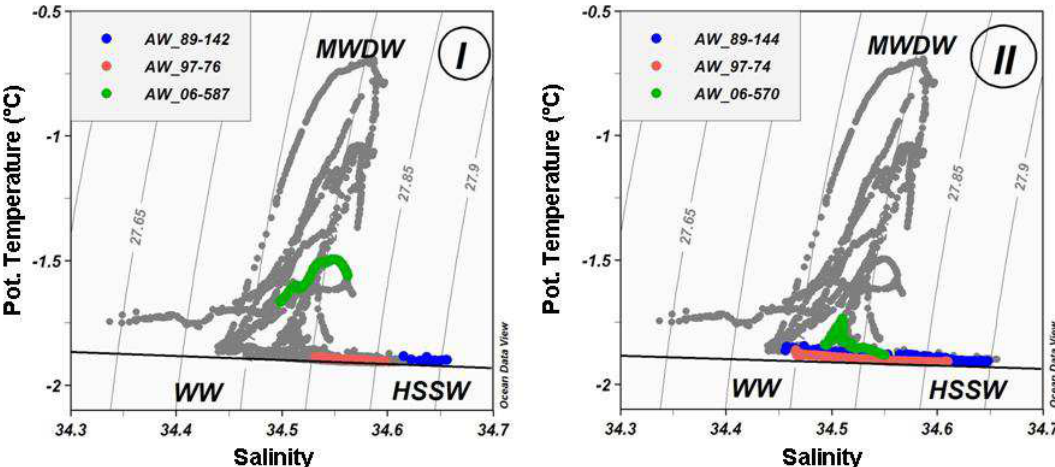
Fig. 3. Austral winter θ /S–characteristics on the shallow ( < 500m) northwestern Weddell Sea continental shelf for cruises AW 89, AW 97, and AW 06, in gray, together with selected stations from the areas I and II (Fig. 1b), sampled during austral winters of 1989 (blue), 1997 (red), and 2006 (green). The lower line represents the surface freezing temperature as a function of salinity. Isopycnals are drawn relative to surface pressure ( σ 0 ). MWDW = Modified Warm Deep Water, WW = Winter Water, HSSW = High Salinity Shelf Water.